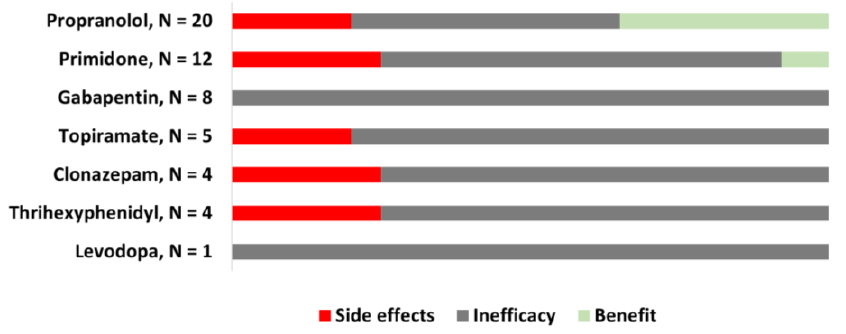
Figure 1. Effect of oral medications for dystonic tremor of the upper limbs. The most frequently prescribed oral medications for tremor were propranolol (64.5%), primidone (38.7%), and gabapentin (25.8%). Benefits were only reported with propranolol (35%) and primidone (8%). Topiramate, clonazepam, trihexyphenidyl, and levodopa, were either ineffective or caused side effects (topiramate in 20%, clonazepam in 25%, and trihexyphenidyl in 25%).